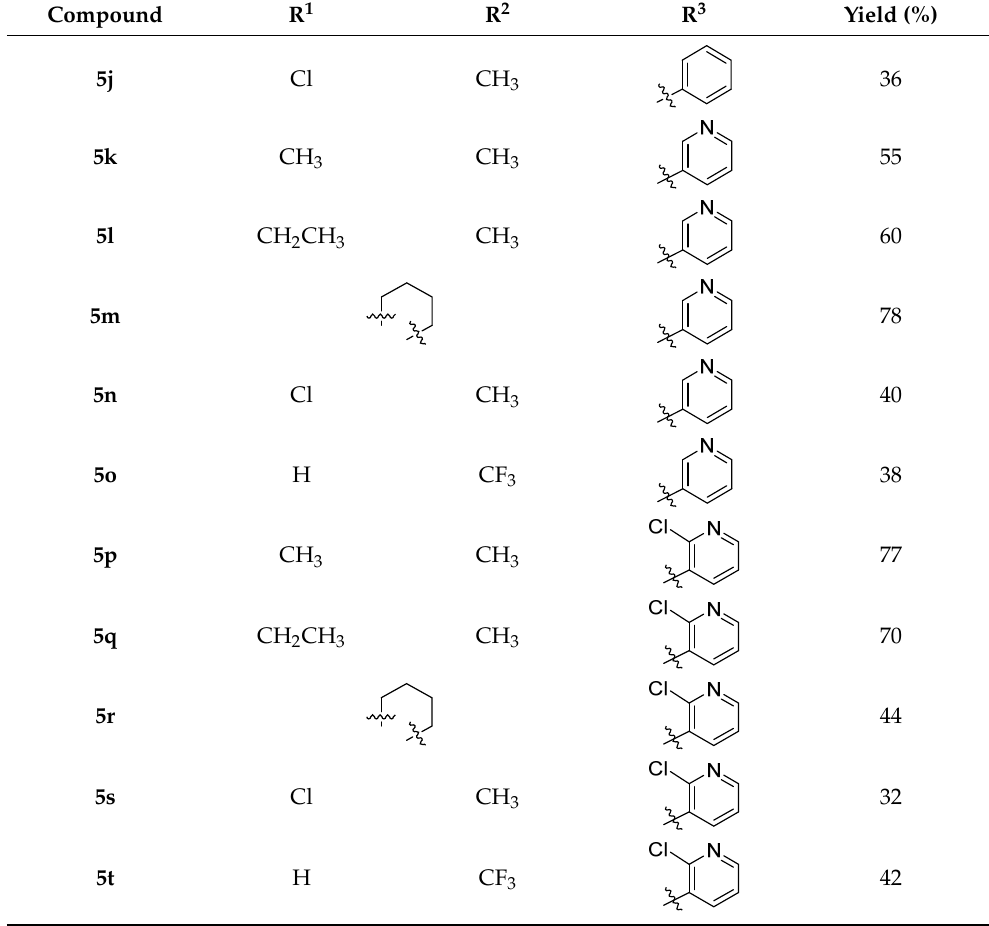
Table 2. Structures and yields of compounds 6 .